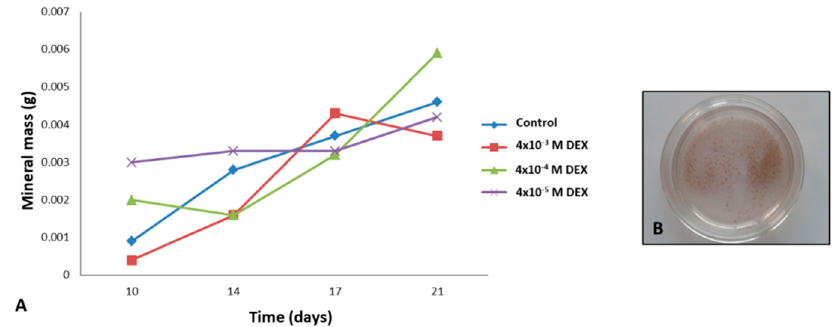
Figure 5. ( A ) Mass of deposited minerals in grams released from DEX loaded RADA 16-I scaffolds to media collected during the 21 days of culture in a perfusion bioreactor. ( B ) Presence of minerals in collected media confirmed with von Kossa staining.